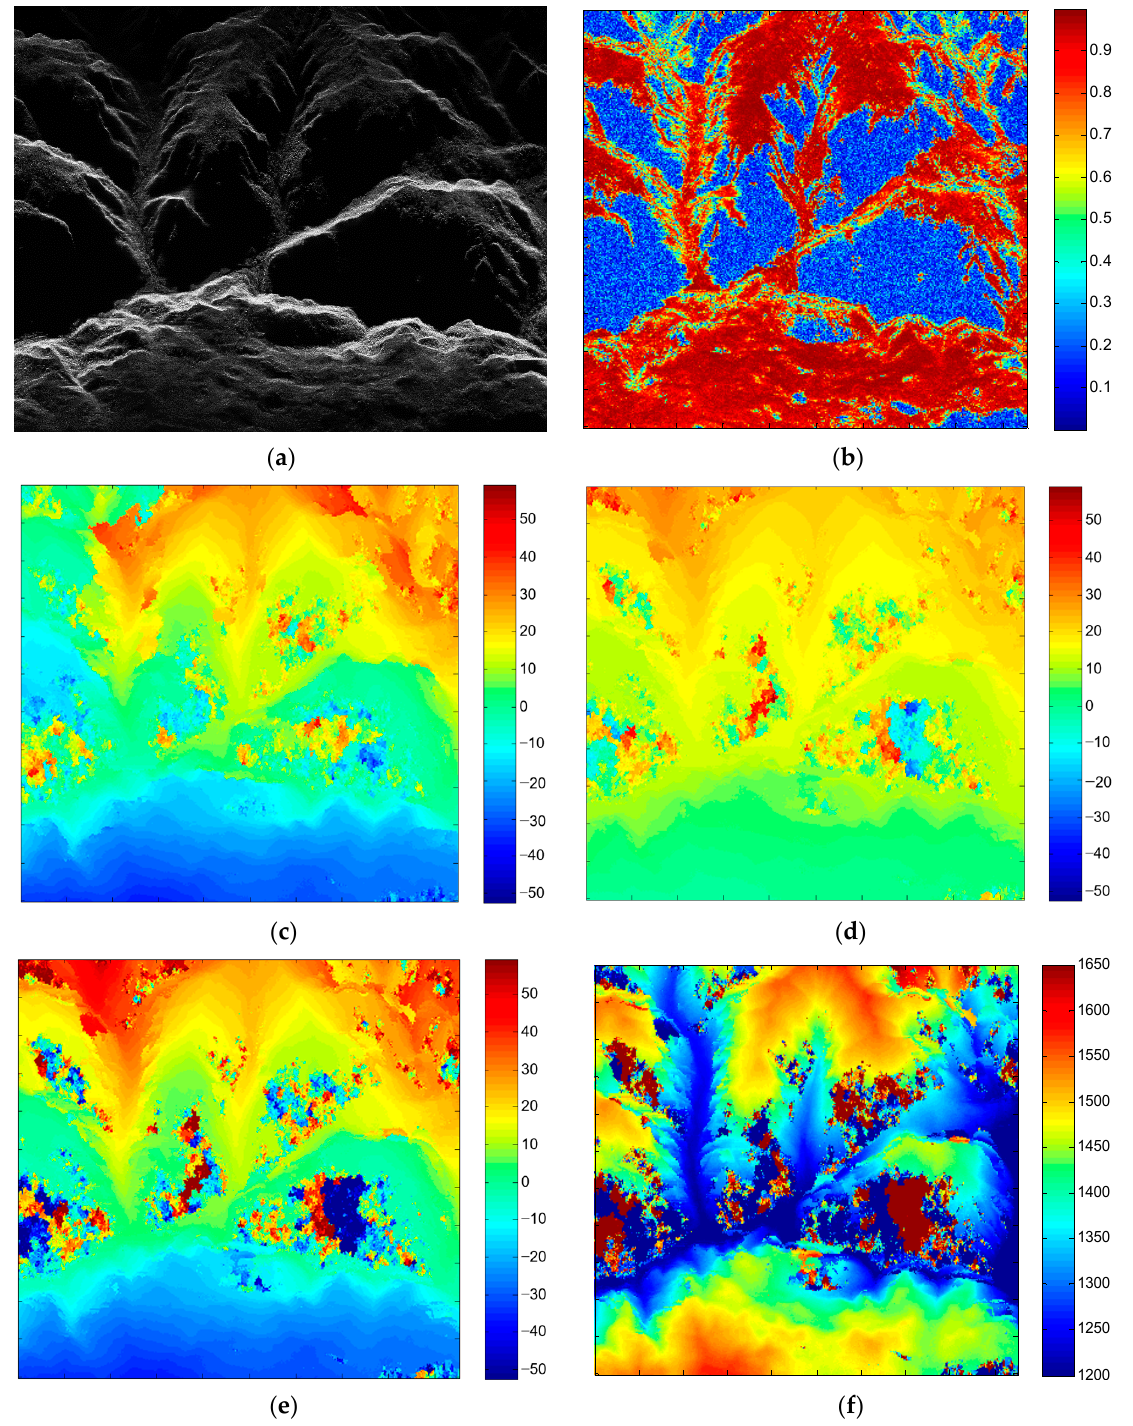
Figure 25. Phase processing and elevation inversion of data block containing shadow area, where ( a ) is the amplitude image, ( b ) is coherence coefficient diagram, ( c ) is the result of conventional phase unwrapping, ( d ) is the phase unwrapping result of short baseline, ( e ) is the phase unwrapping result of long baseline and ( f ) is the elevation inversion result.